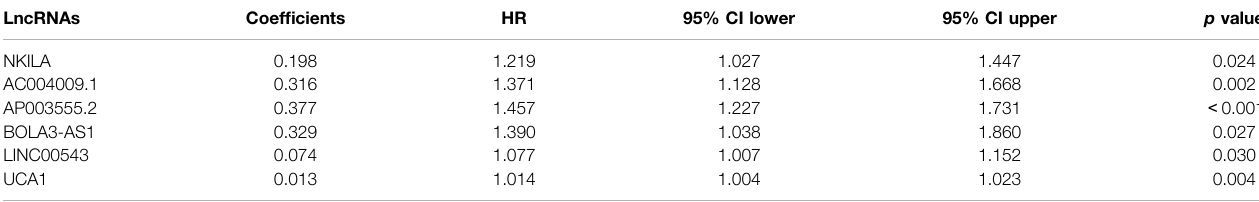
TABLE 1 | DRPM information including six DGIA lncRNAs. LncRNAs